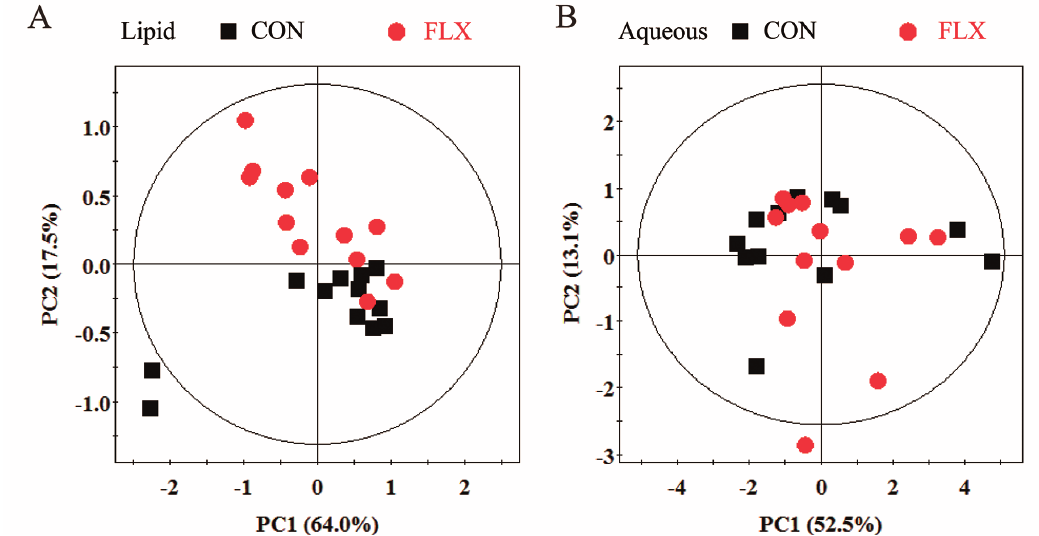
Figure 4. PCA score plot based on 1 H NMR spectra for the lipid ( A ) and aqueous ( B ) phases of cellular extracts obtained from CON (black box ■ ) and FLX (red dot ●